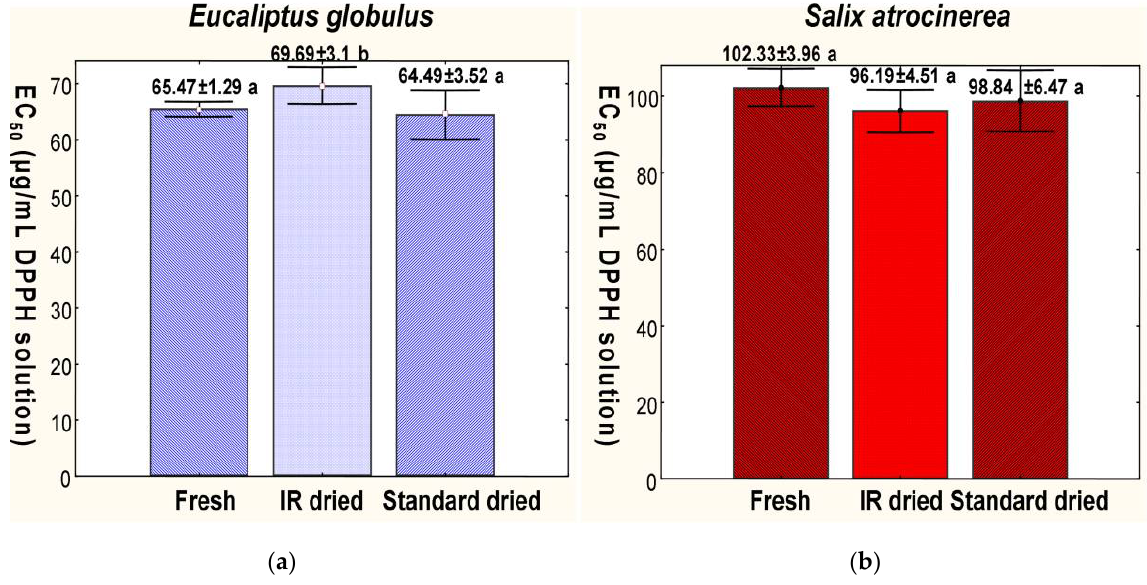
Figure 3. DPPH assay results for different drying methods expressed as EC50 (μg/mL DPPH solution). Results represents means ± SD (n = 3) ( a , b ) groups concordance by t -test analysis for variance ( p ≤ 0.05): ( a ) Data from Eucalyptus globulus bee pollen samples; ( b ) Data from Salix atrocinera bee pollen samples.